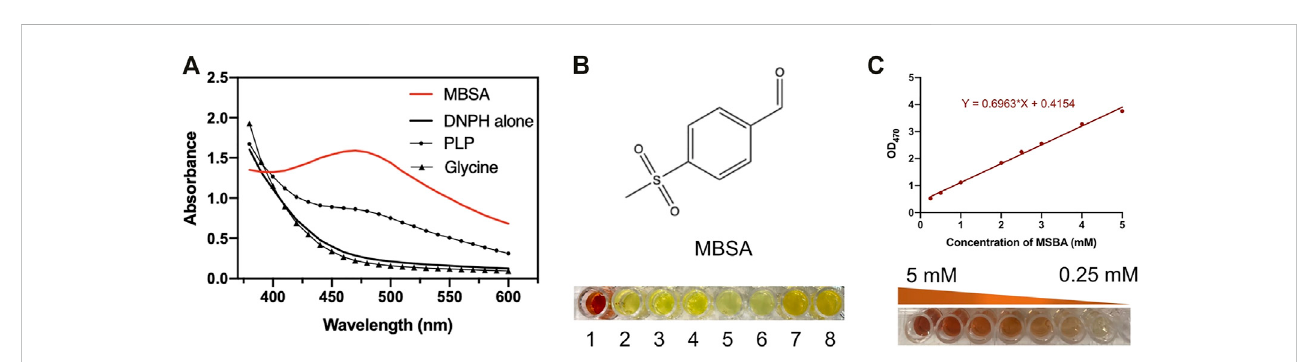
FIGURE 3 (A) Absorbance spectra of MSBA, PLP, Glycine, and DNPH; (B) Red-brown color formation between different alkalis including NaOH, KOH, Na 2 CO 3 ,